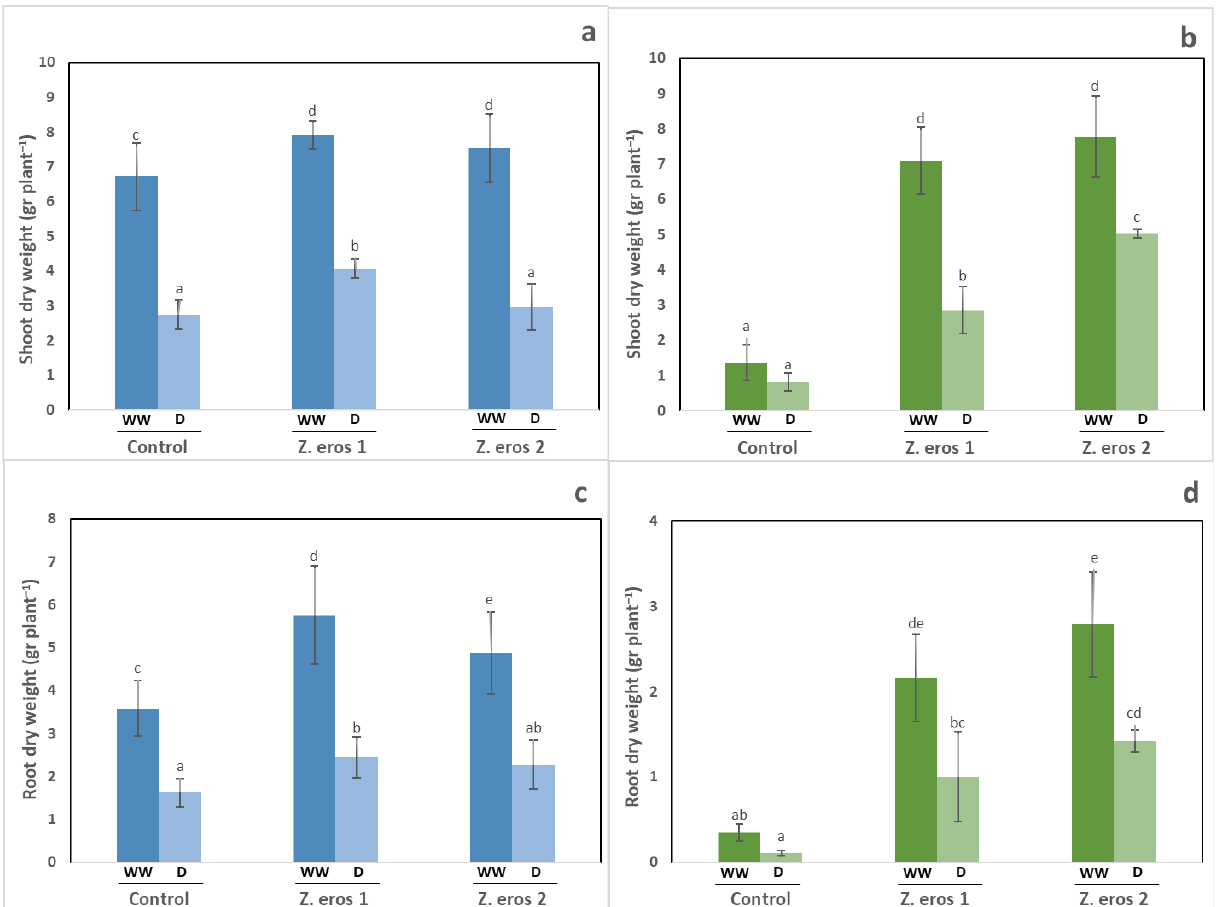
Figure 1. Shoot and root dry weight of wheat plants ( a , c ) and tomato plants ( b , d ) inoculated with the fungal endophytes Z. erostrata 1 y Z. erostrata 2 and cultivated under well-watered (WW) and drought stress (D) conditions. The data are the means ± standard deviation of ten replicates. Different letters indicate significant differences between all treatments, according to Duncan’s multiple-range test ( p < 0.05).